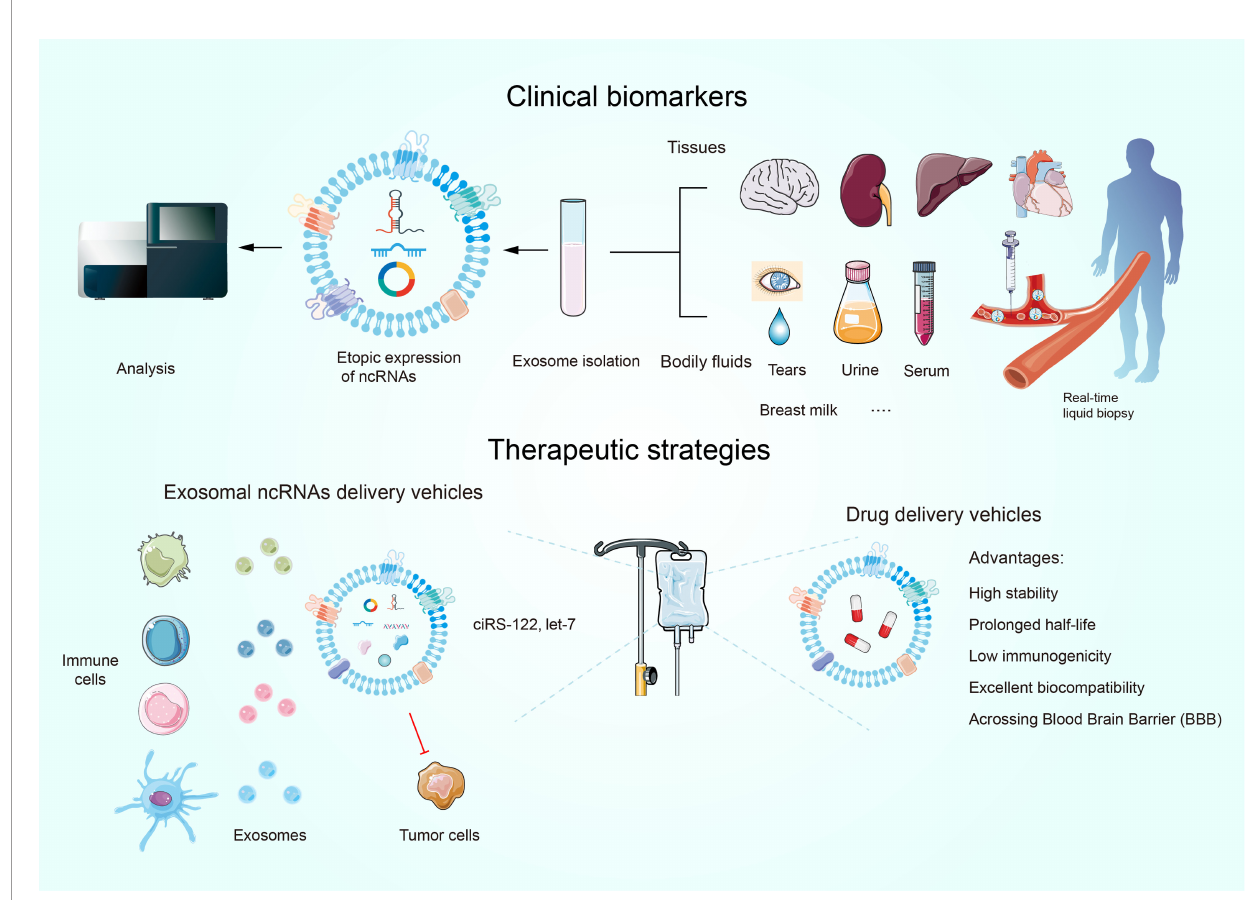
FIGURE 5 | Exosomal ncRNAs as promising biomarkers for the diagnosis and prognosis of human cancers. Exosomes have novel therapeutic